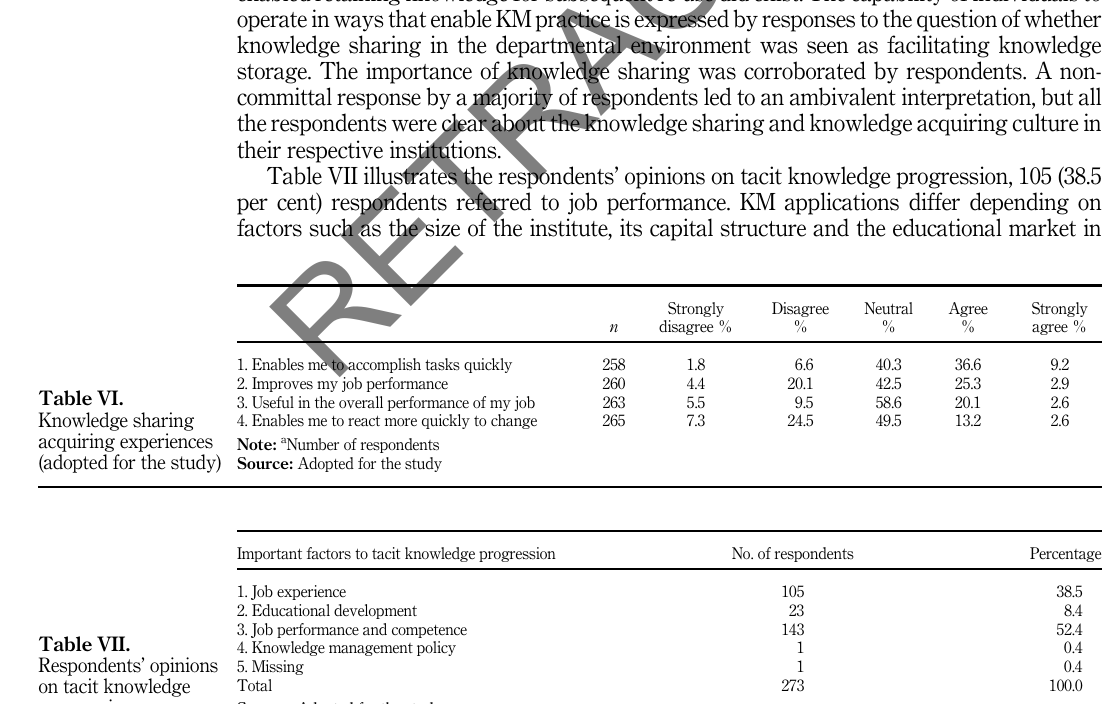
Table VII. Respondents ’ opinions on tacit knowledge